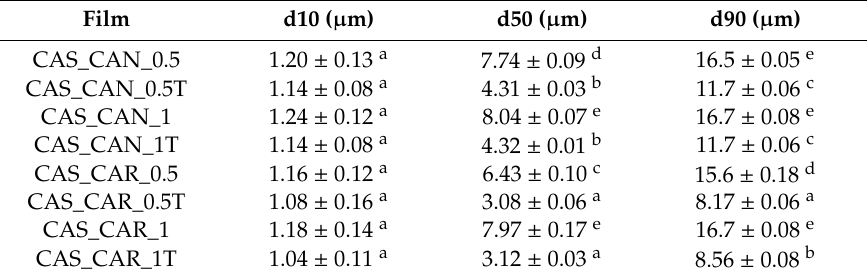
Table 2. Particle size distribution (d10, d50, and d90) in film-forming